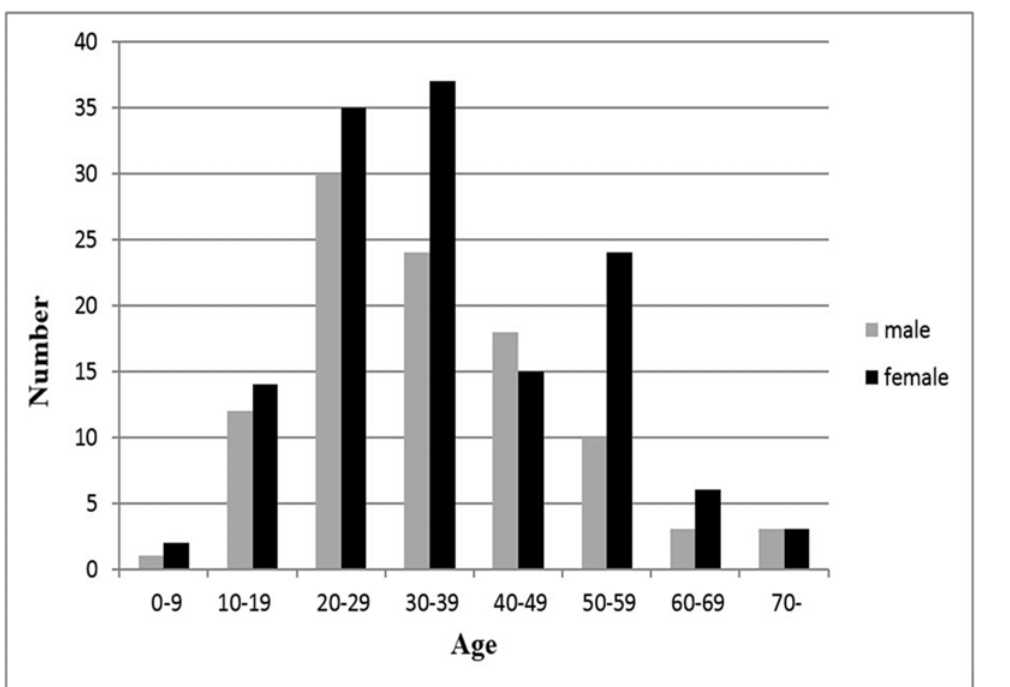
Fig 2. Age distribution of 237 PVNS patients by gender.